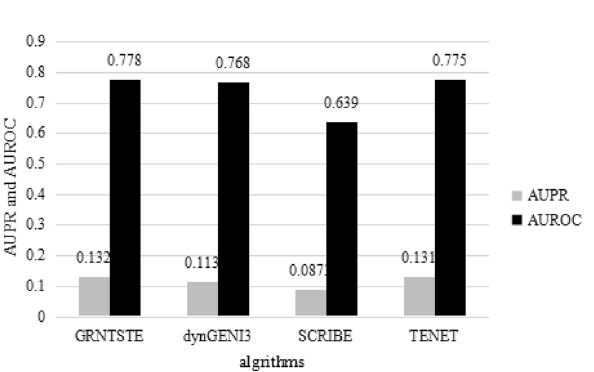
Figure 1. The average value of AUPRC and AUROC obtained for GRNTSTE, dynGENIE3, SCRIBE and TENET algorithms on the datasets with 10 genes.